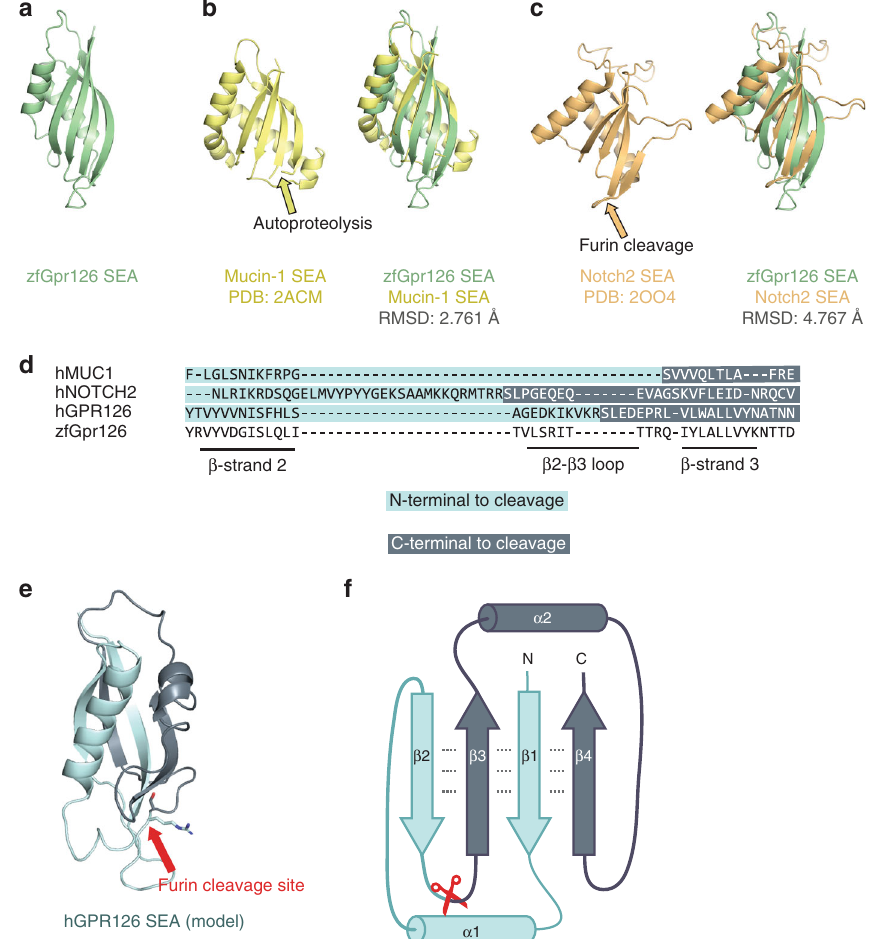
Fig. 6 Identi fi cation of a proteolytic SEA domain in human GPR126. a Crystal structure of the SEA domain from zebra fi sh Gpr126. b (left) NMR structure of Mucin-1 SEA domain (PDB: 2ACM) and (right) Gpr126 SEA domain superimposed over Mucin-1 SEA domain. The loop containing the autoproteolysis site in Mucin-1 is indicated by a yellow arrow. The root-mean-square deviation (RMSD) of atoms between overlaid structures is 2.761Å. c (left) Crystal structure of the Notch2 SEA domain (PDB: 2OO4) and (right) Gpr126 SEA domain superimposed over Notch2 SEA domain. The loop containing the furin- cleavage site (deleted in crystal structure construct) is indicated by an orange arrow. The RMSD of atoms between overlaid structures is 4.767 Å. d Sequence alignment of partial SEA domain from human Mucin-1, human Notch2, human GPR126, and zebra fi sh Gpr126. e Homology model of human GPR126 SEA model generated using SWISSMODEL. The arrow points to modelled furin-cleavage site. f Protein topology map of SEA domain. Furin- cleavage site is indicated by red scissors. Residues N-terminal to cleavage site are dark blue and residues C-terminal to cleavage site are light blue. Dashed lines represent backbone hydrogen bonds between